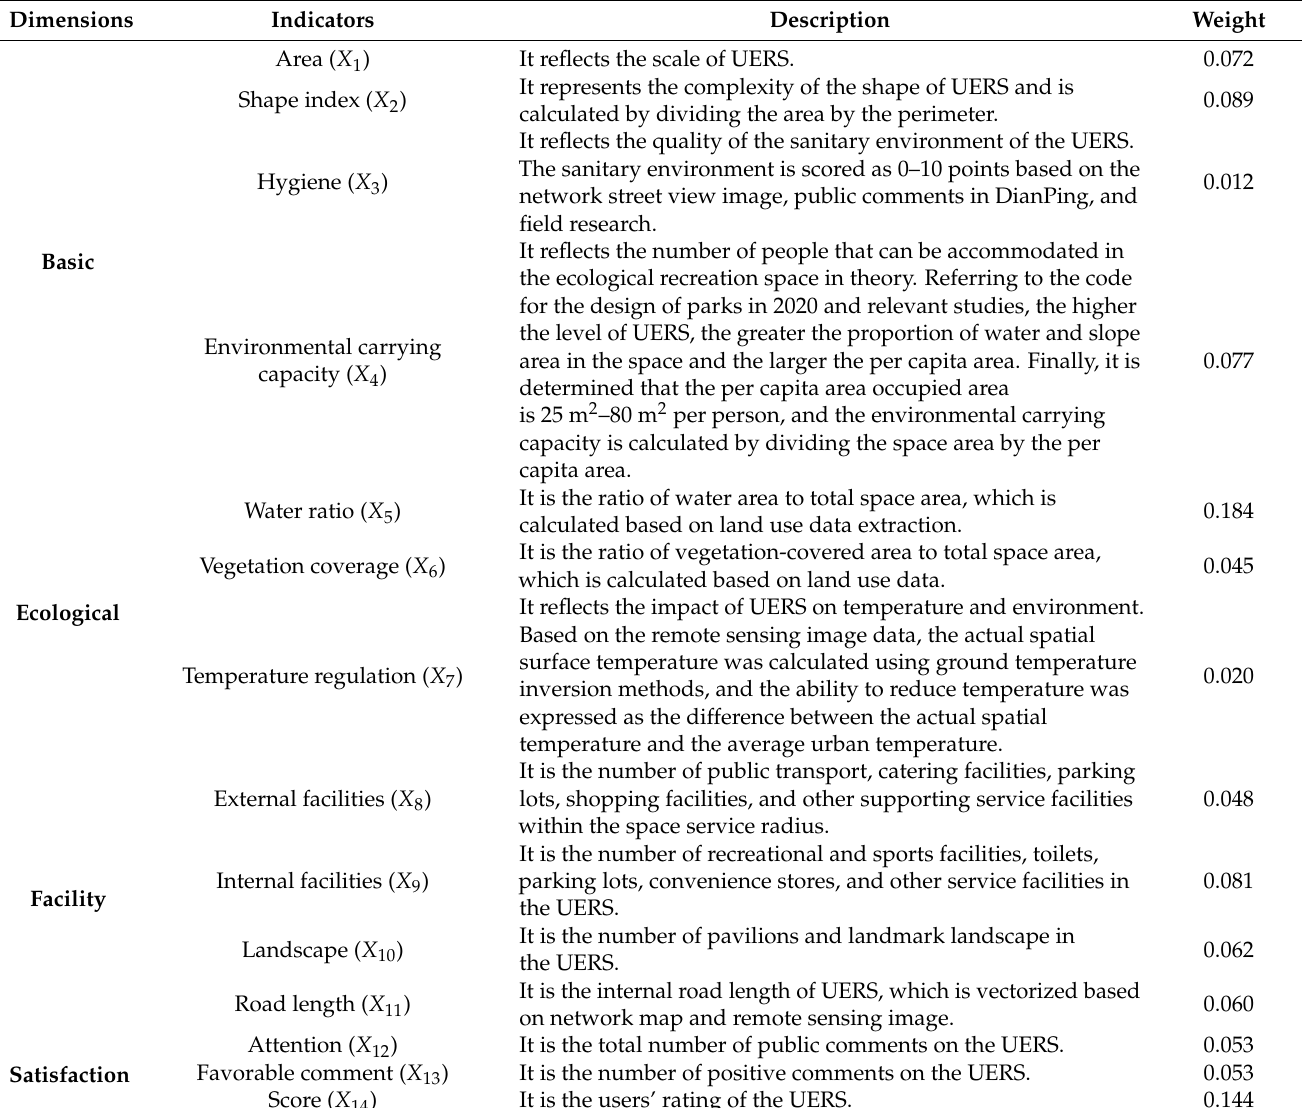
Table 2. UERS quality measurement indicators and data